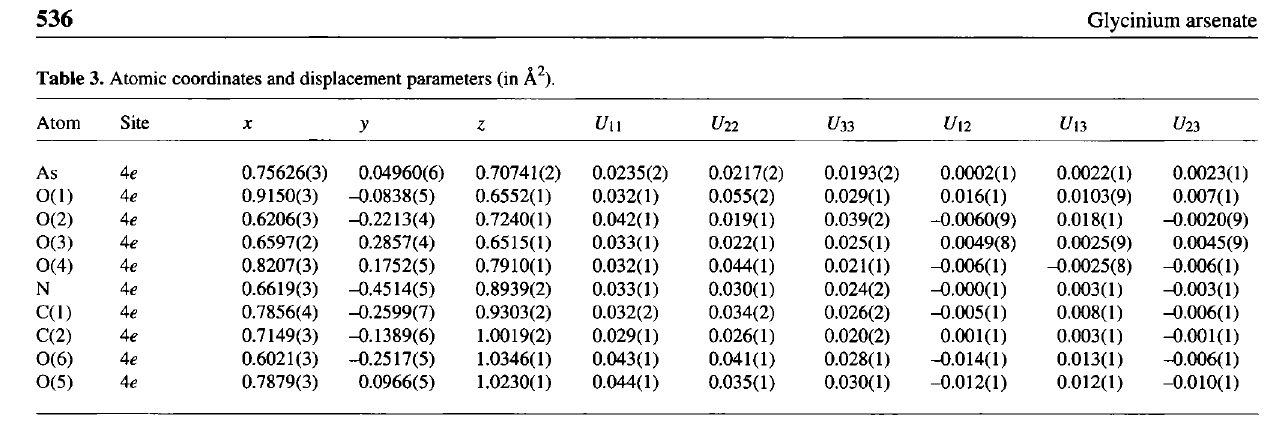
Table 3. Atomic coordinates and displacement parameters (in Ä 2